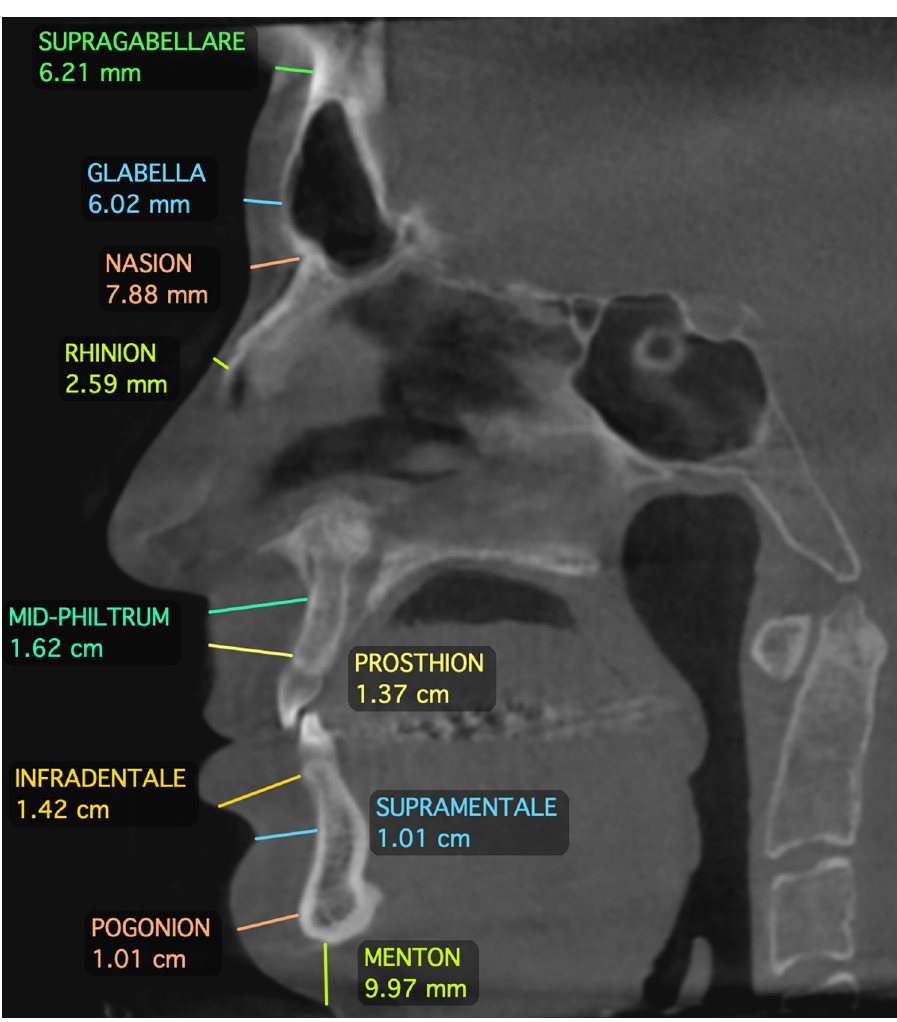
Fig 2. Sagittal landmarks